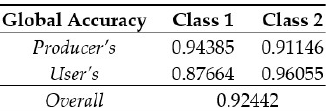
Table 3. Classifier global accuracies by the Bayes classifier.